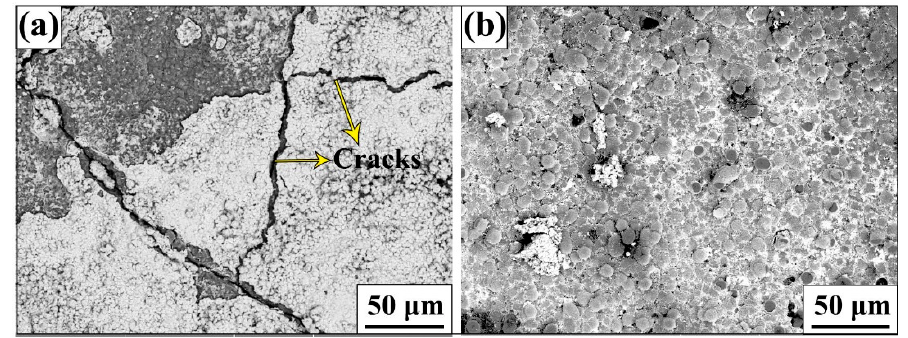
Figure 8. The SEM pictures of ablated ZrC/SiC coating ( a ) and ZrC-SiC coating ( b ) at transition ablation region.